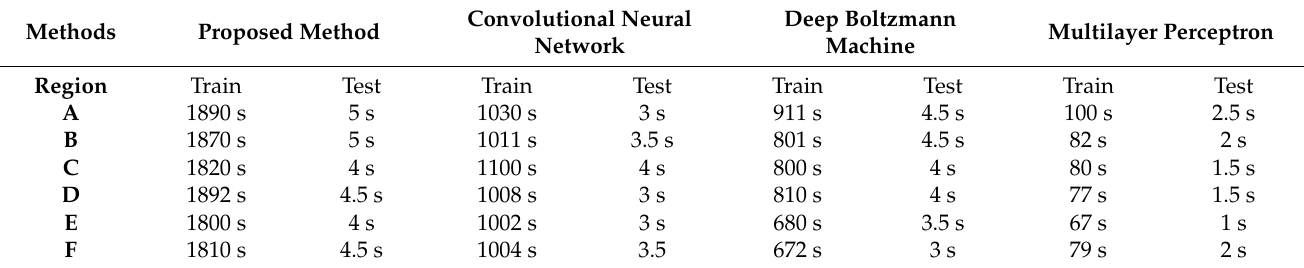
Table 5. Classification accuracy of the suggested method compared with other methods of comparison.